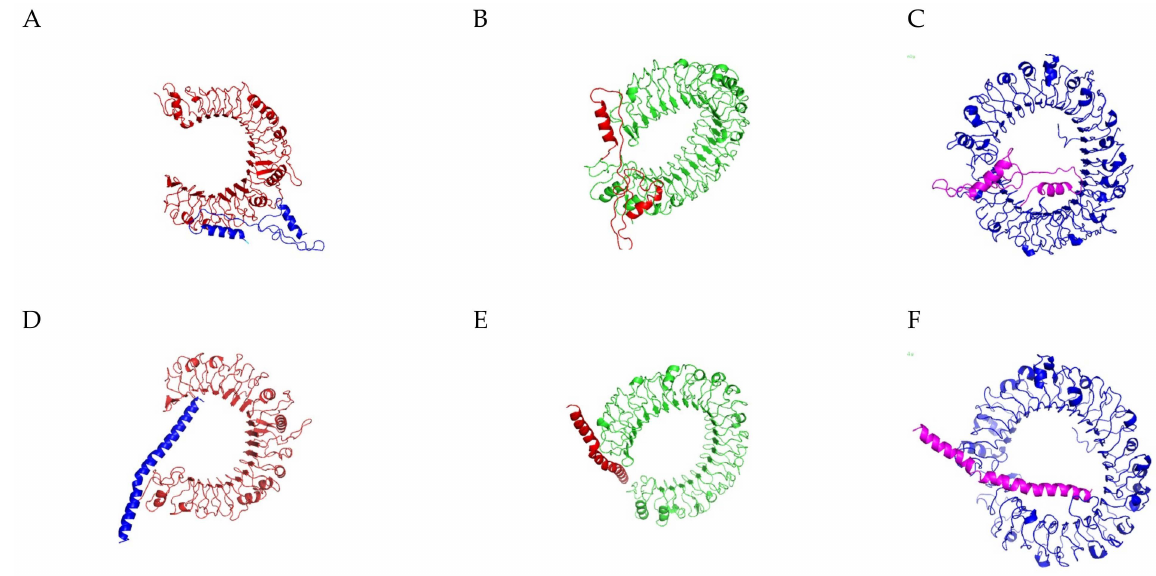
Figure 4. ( A – F ) Docked complexes of TLR-2, TLR-4, and TLR-9 with VT1 ( A – C ) and VT2 ( D – F ) peptides.